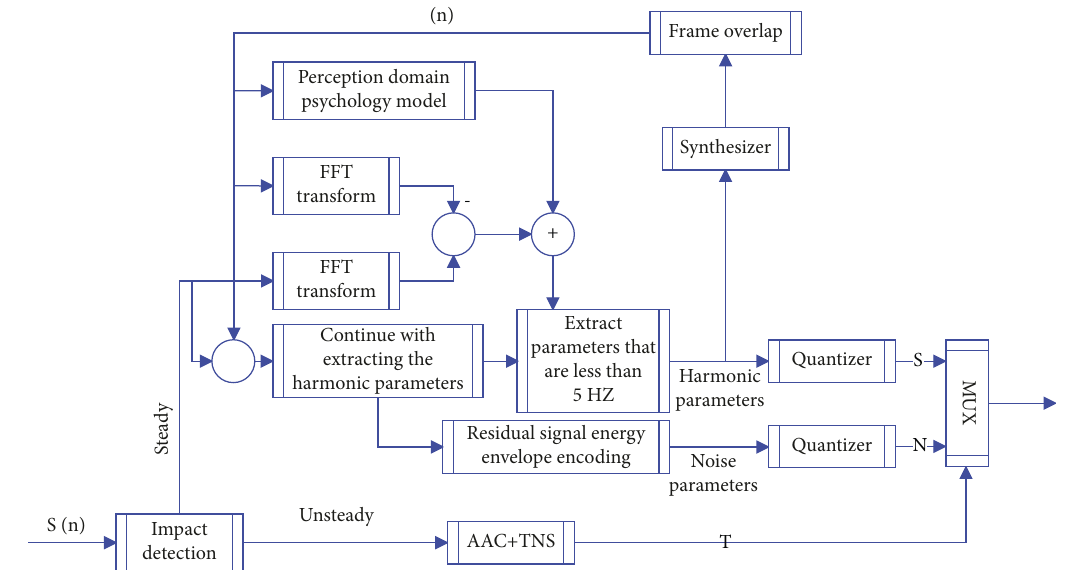
Figure 9: The model of the parametric audio hybrid encoder chosen in this